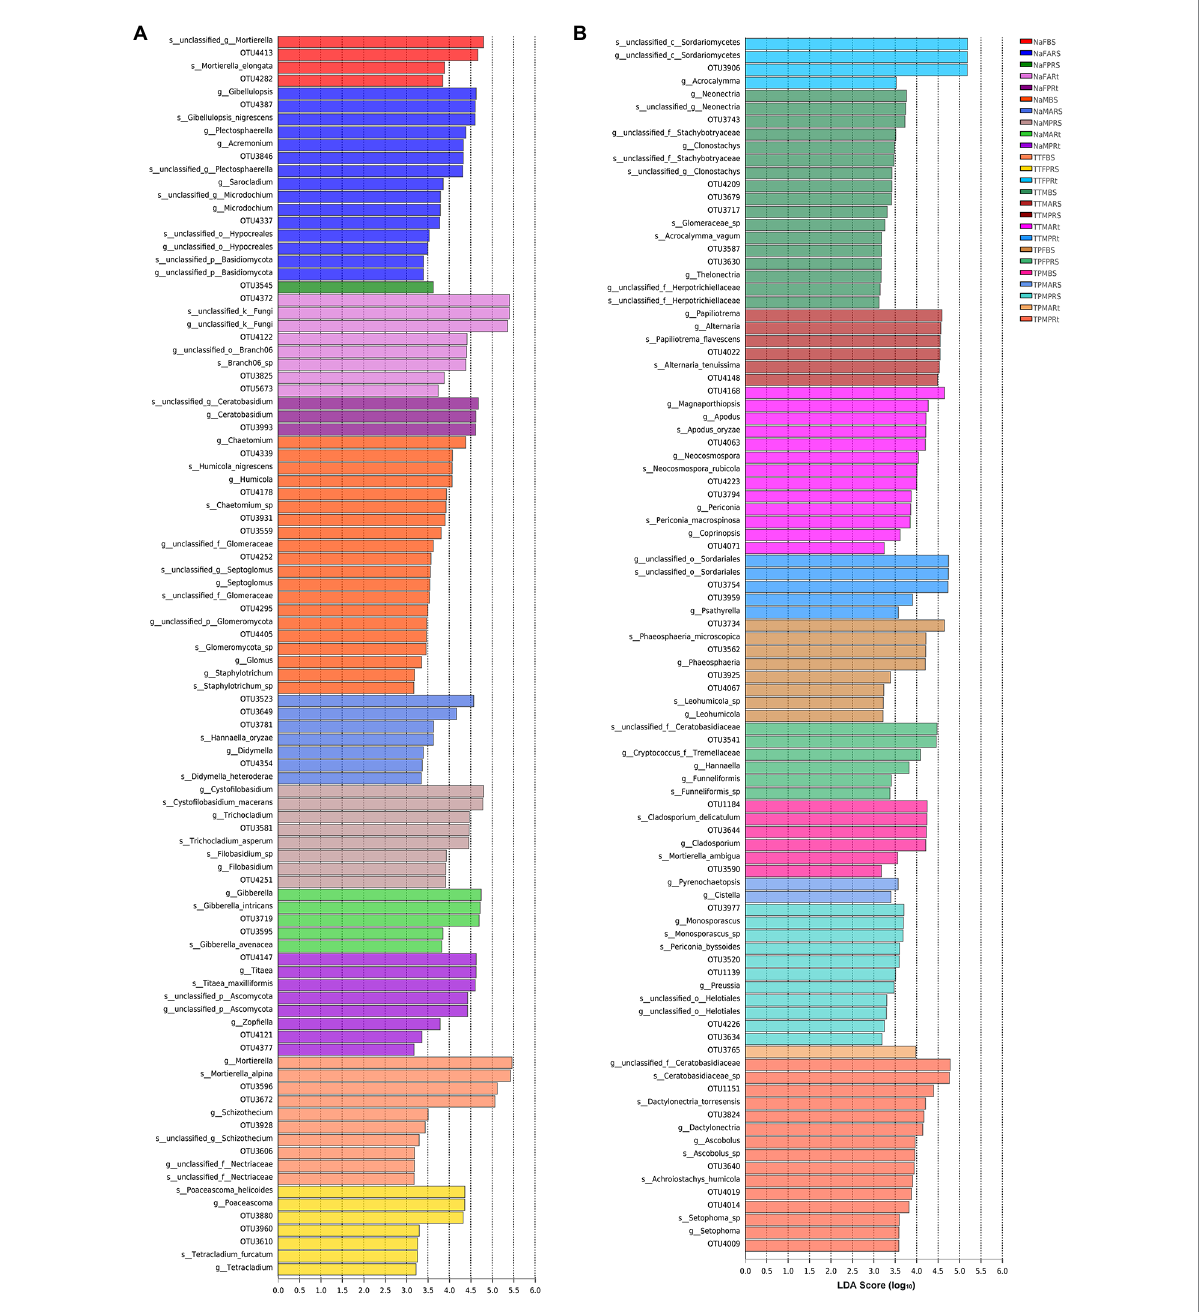
FIGURE 6 Taxa significantly enriched in bulk soil, rhizosphere and root compartments among 25 sample groups via linear discriminant analysis (LDA) by LEfSe. (A) Twelve groups in the whole PDF file; (B) 13 other groups in the whole PDF file. LDA score (log 10 ) = 3; comparison based on all samples- against-all samples from genus to OTU. The treatment details are shown in Figure